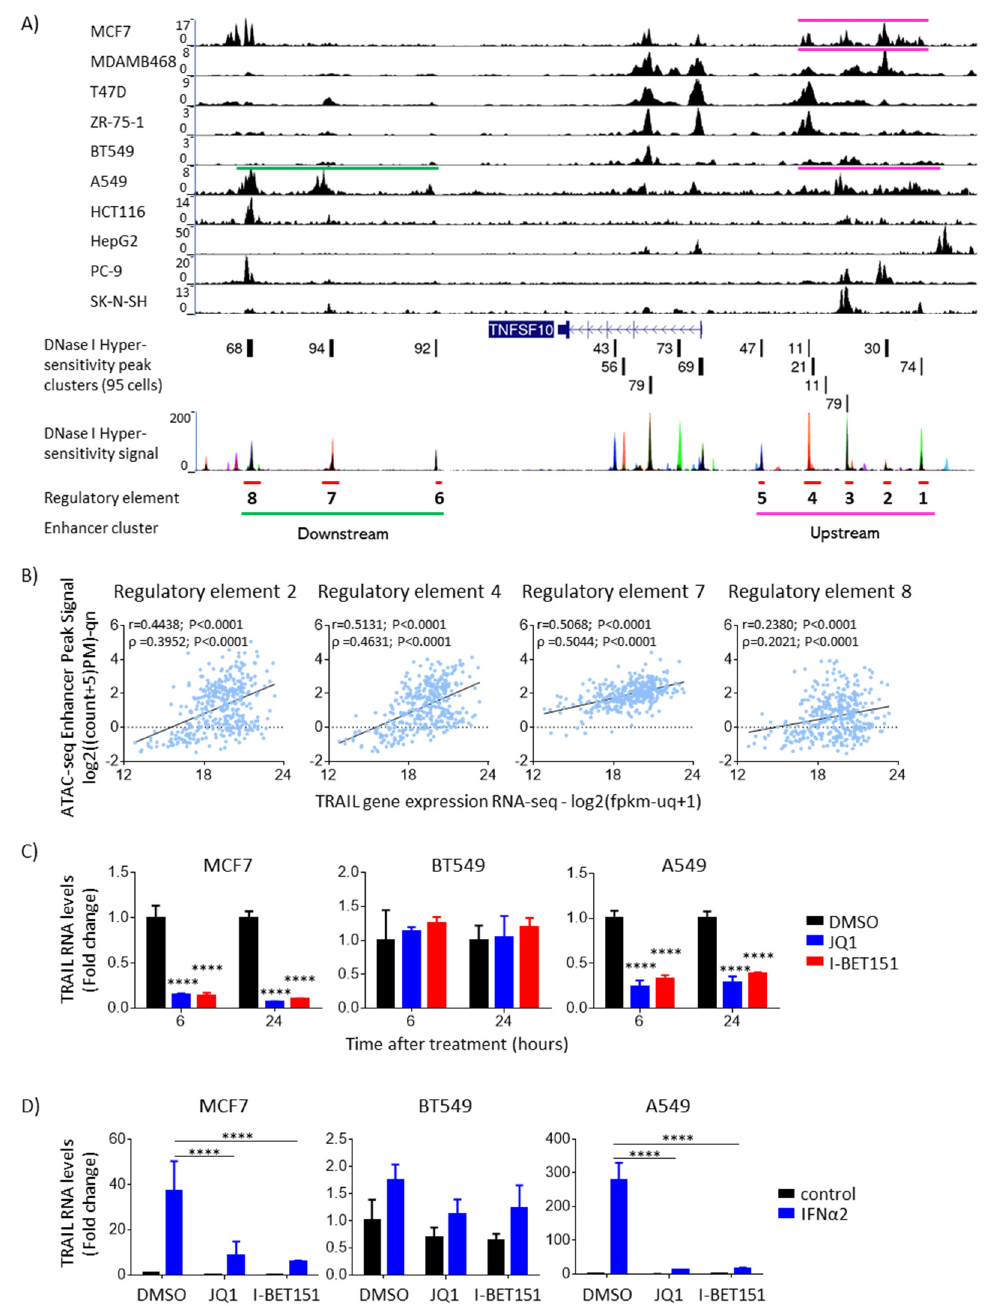
Figure 2. Enhancer clusters mediate TRAIL upregulation by IFN α . ( A ) TRAIL is associated with enhancer clusters in specific cancer cell lines. Publicly available H3K27ac ChIP-seq data for several cell lines from breast cancer (MCF7, MDAMB468, T47D, ZR-75-1 and BT549) and other solid cancers (A549, HCT116, HepG2, PC-9 and SK-N-SH) were analyzed. Peaks of H3K27ac signal represent accessible chromatin and were found upstream and downstream of TRAIL (TNFSF10), which is transcribed from the opposite strand (right to left). Distal H3K27ac peaks overlapping with DNase I hypersensitive sites (a mark of open regulatory DNA) indicate accessible open DNA regions carrying putative regulatory elements. Distal DNase I hypersensitive sites, called regulatory elements 1 to 8 and shown in red in the diagram, were identified through DNase I hypersensitivity assays in 95 cell lines from ENCODE. Only distal DNase I hypersensitive regions that were found in more than 20 out of the 95 cell lines were considered as putative regulatory elements in this analysis. Regulatory elements 1 to 5 cluster together upstream of TRAIL (to the right in the figure), whereas regulatory elements 6 to 8 cluster together downstream of TRAIL (to the left in the figure). Upstream